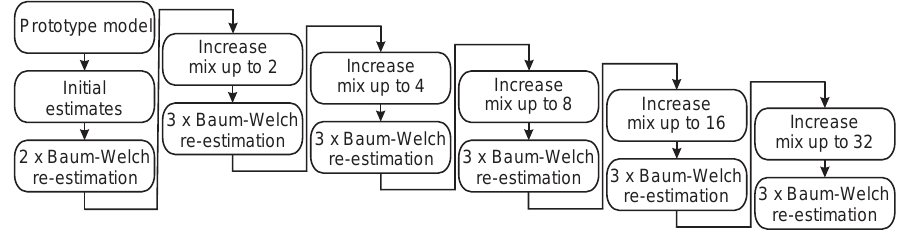
Figure 5. The GMM training procedure with up to 32 Gaussian mixtures per state.